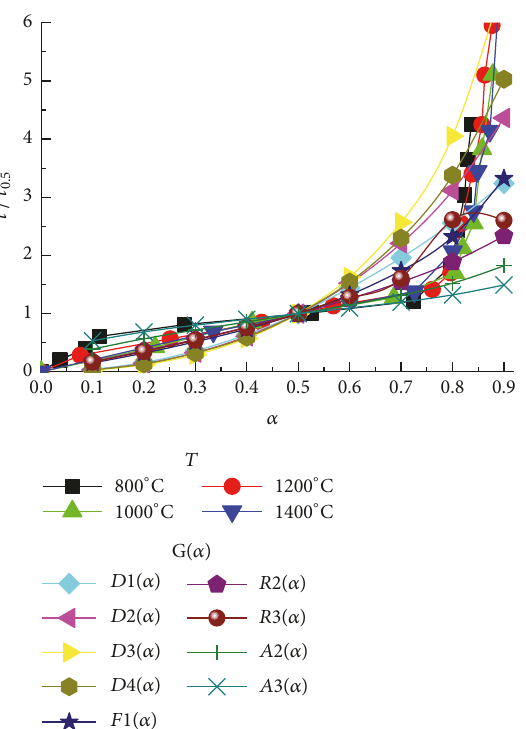
Figure4:Mostprobablemechanismfunctionfittingcurvesofwood pellet combustion